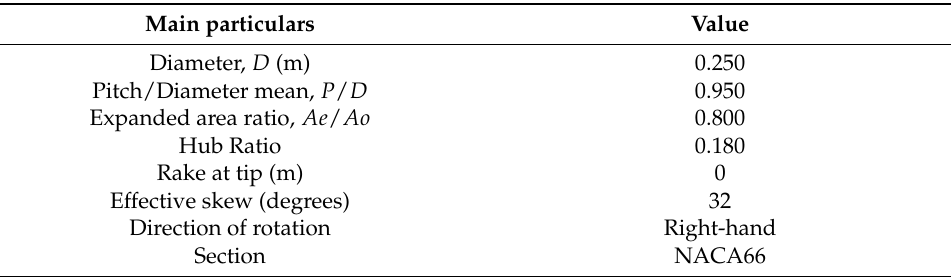
Table 1. Main particulars of the KP505